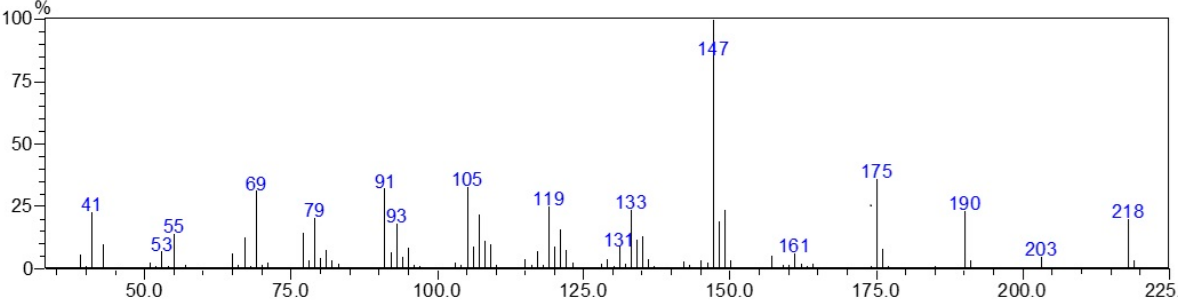
Figure A1. Oxygenated sesquiterpene unidentified MW218.